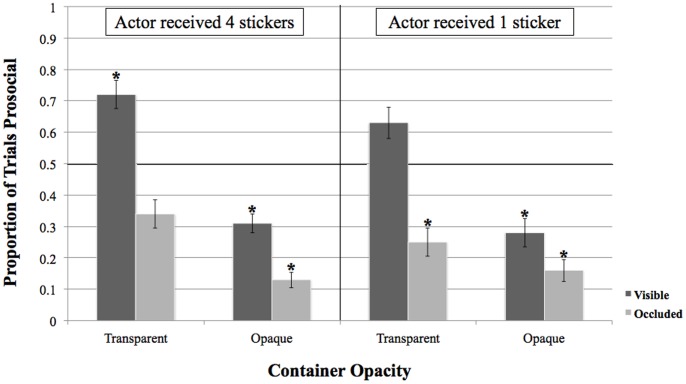
Main Findings.Mean proportion of prosocial giving (distributing four stickers rather than one sticker to the recipient) by visibility (visible versus occluded), container opacity (opaque versus transparent), and actor’s allocation value (one sticker versus four stickers).